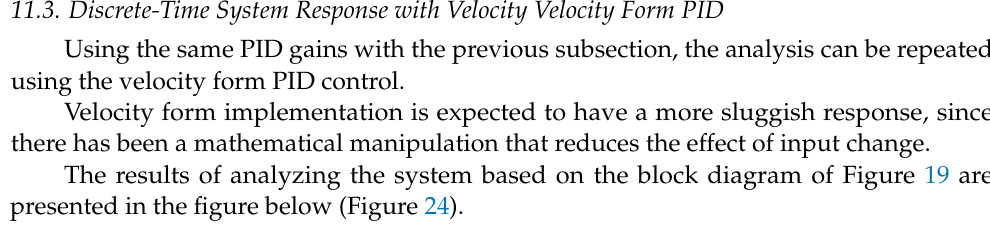
Figure 23. Comparison of equation implementation to block implementation.